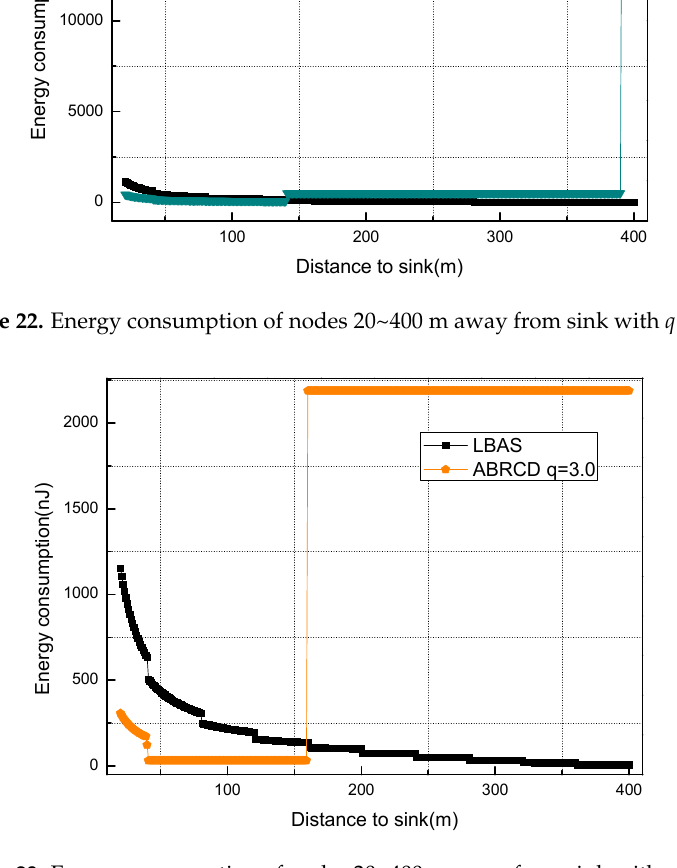
Figure 23. Energy consumption of nodes 20~400 m away from sink with q = 3.0.